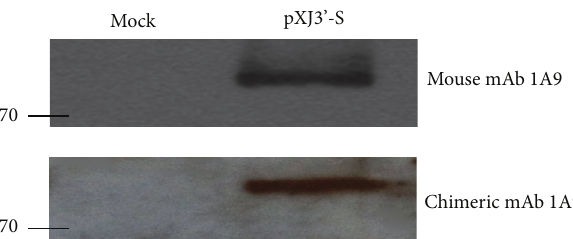
Figure2:WesternblotanalysisforthedetectionofSARS-CoVspike (S) protein (210kDa). HEK 293-FT cells were transfected with no plasmid (mock) or with plasmid expressing full-length S, pXJ3 󸀠 -S. Cell lysates were separated in a 7.5% SDS-PAGE gel and detected using mouse mAb 1A9 and human-mouse chimeric mAb 1A9 via Western blot analysis as previously described [23]. Molecular weight markers (in kilodaltons) are indicated on the